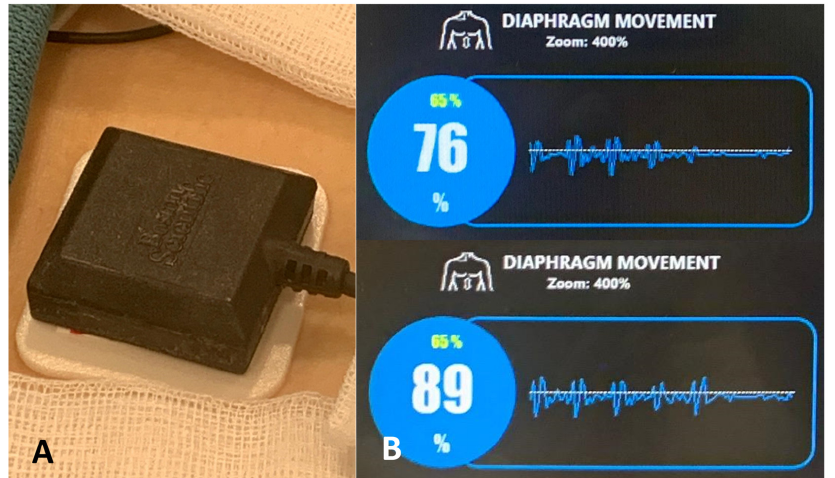
Figure 1. Novel diaphragm movement sensor (DMS). ( A ) The novel diaphragm movement sensor is placed on an electrode below the right-sided costal cartilage. ( B ) Section of the SMARTFREEZE Cryoablation Console surface with visualization of the DMS during pacing of the right-sided phrenic nerve and isolation of the right inferior pulmonary vein.